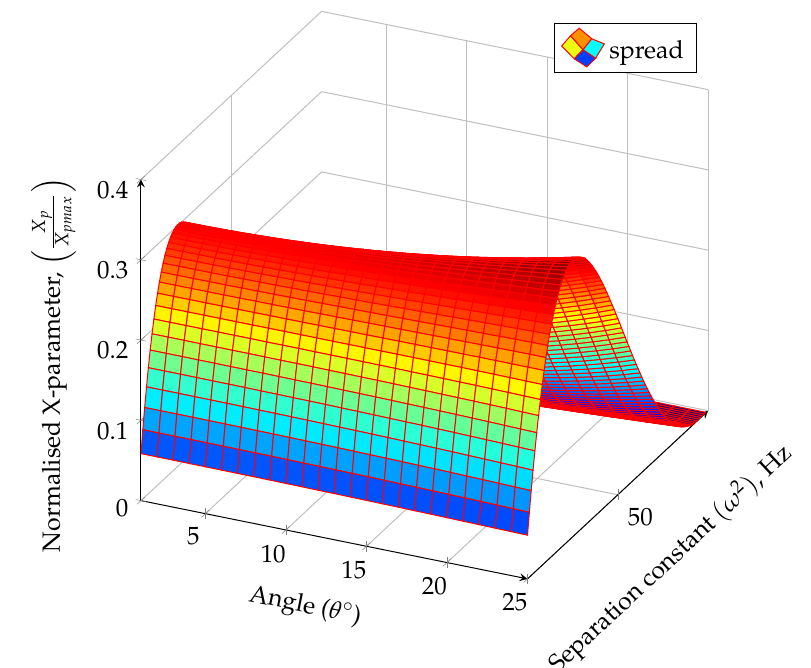
Figure 8. 3D plot of X -parameter ( X p ) as a function of the separation constant ( ω 2 ) and angle ( θ ◦ ) at time t = 30